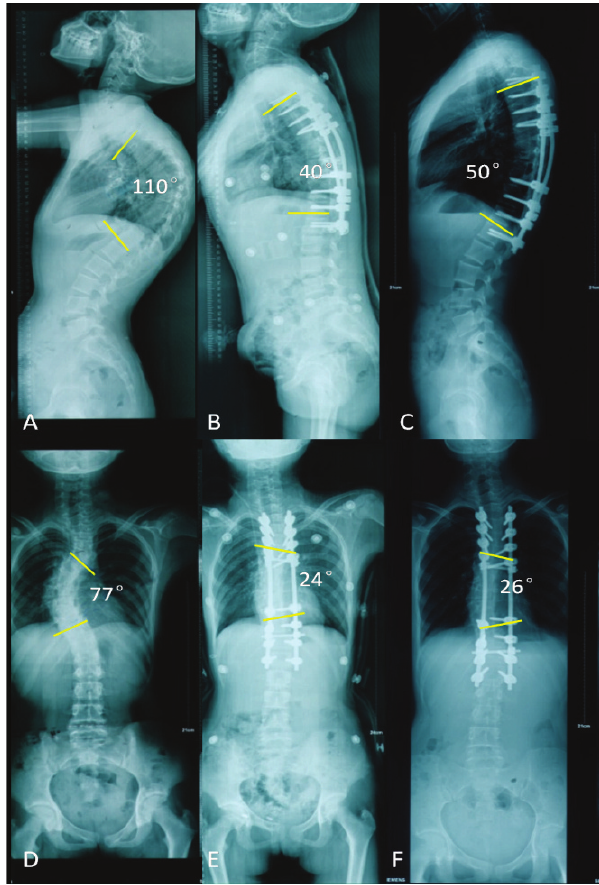
Figure 3 - Pre-operative, immediate post-operative and 24 month post-operative radiographs. The coronal Cobb angles (A-C) were defined by the angles between the two end vertebra(yellow lines), and sagittal kyphosis (D-F) was defined by the angles between T2 and T12(yellow lines). A and D)The preoperative coronal and sagittal images showed sharp and short segmental coronal deformity and significant sagittal hyperkyphosis in the thoracic region; B and E) The immediate post-operative coronal and sagittal images showed significant correction of the deformity in both planes; C and F) The 24 month post-operative coronal and sagittal images showed the well-maintained correc- tion of deformity in both planes, solid fusion within the fused regions was achieved, and all the implants remained in position.